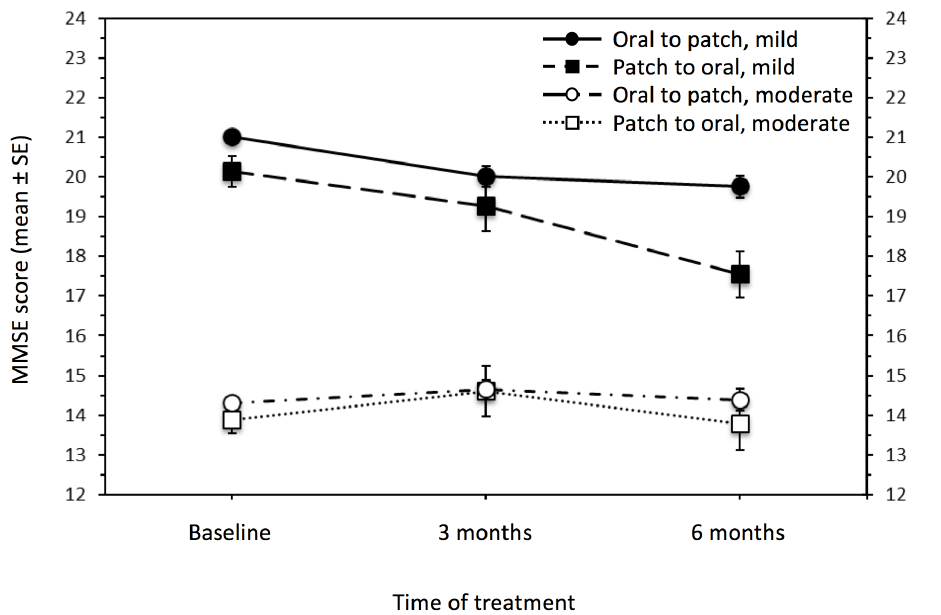
Figure 1. Changes of global cognitive level during ChEI switch. An analysis of variance with repeated measures indicates that the longitudinal course of global cognitive level (i.e. MMSE score changes during a 6-month period) in mild to moderate AD patients performing for the first time a switch to another ChEI due to lack of response/reduced compliance, is more favourable when switching from oral ChEIs to rivastigmine patch, with best effectiveness in mild AD patients (see the results section for statistic details). SE=Standard Error; MMSE=Mini-Mental State